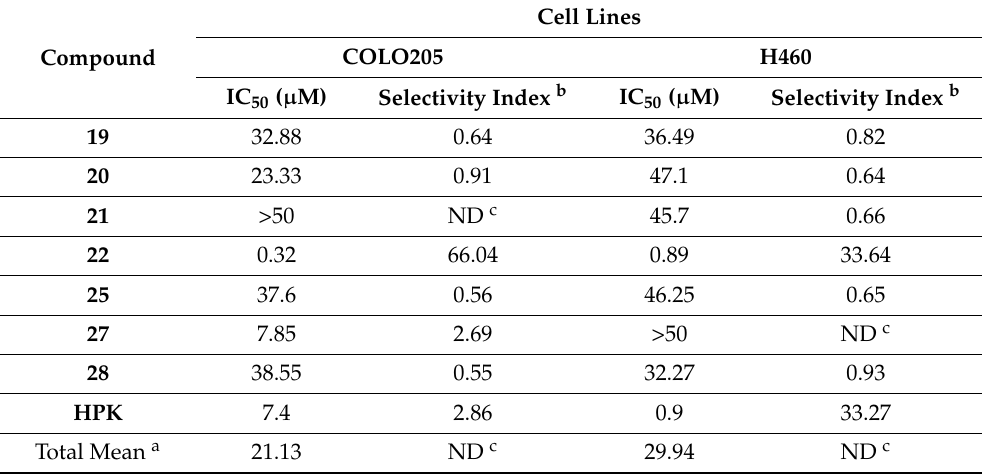
Table 3. Antiproliferative sensitivities of 4-PQ derivatives were analyzed by selectivity index